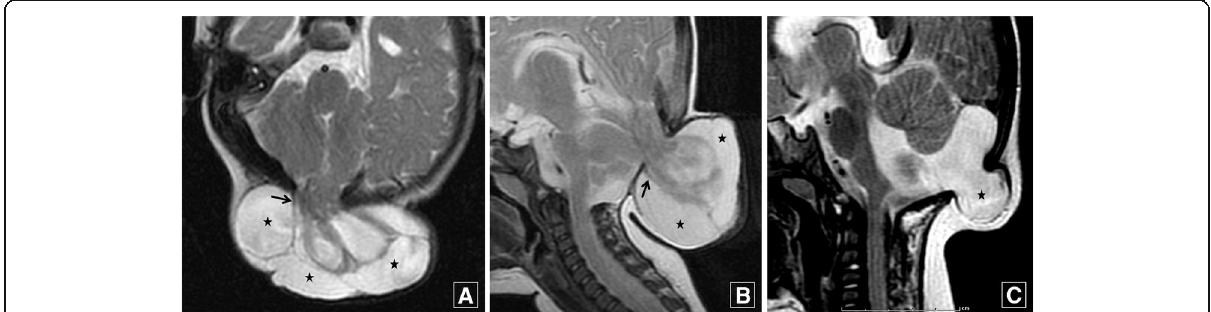
Fig. 8 Occipital meningo-encephalocele and occipital meningocele. ( a ) (T2-weighted axial) and ( b ) (T2-weighted sagittal) images show herniation of CSF (stars) and neuroparenchyma (arrow) through occipital bone defect suggestive of meningoencephalocele. ( c ) (T2-weighted sagittal) image shows herniation of only CSF (star) through occipital defect suggestive of